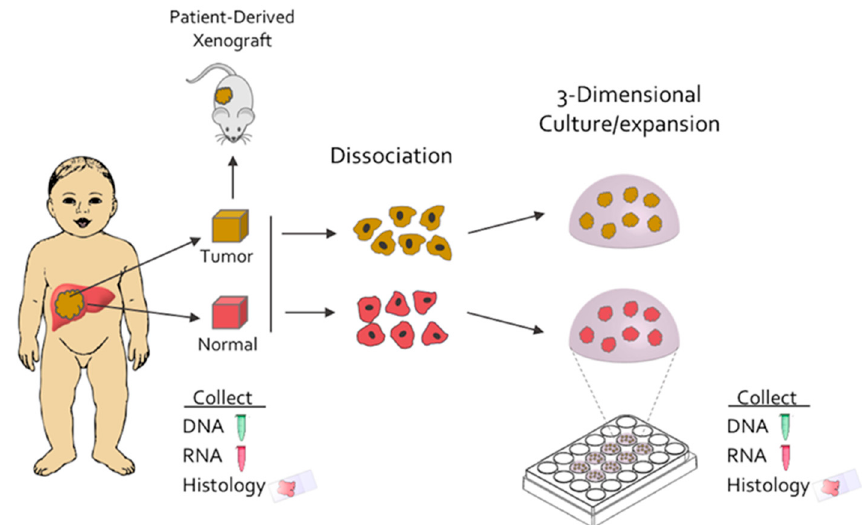
Figure 1. Fresh hepatoblastoma tumor tissue and surrounding normal tissue is collected from patients at the time of surgery. The tissue is dissociated to single-cell suspension and cultured in a 3-dimensional matrix to create tumor and normal liver organoids. Pieces of fresh tumor are also implanted subcutaneously into mice to generate PDXs. Collection of DNA and RNA, and histologic examination is performed at multiple points in the experimental workflow.